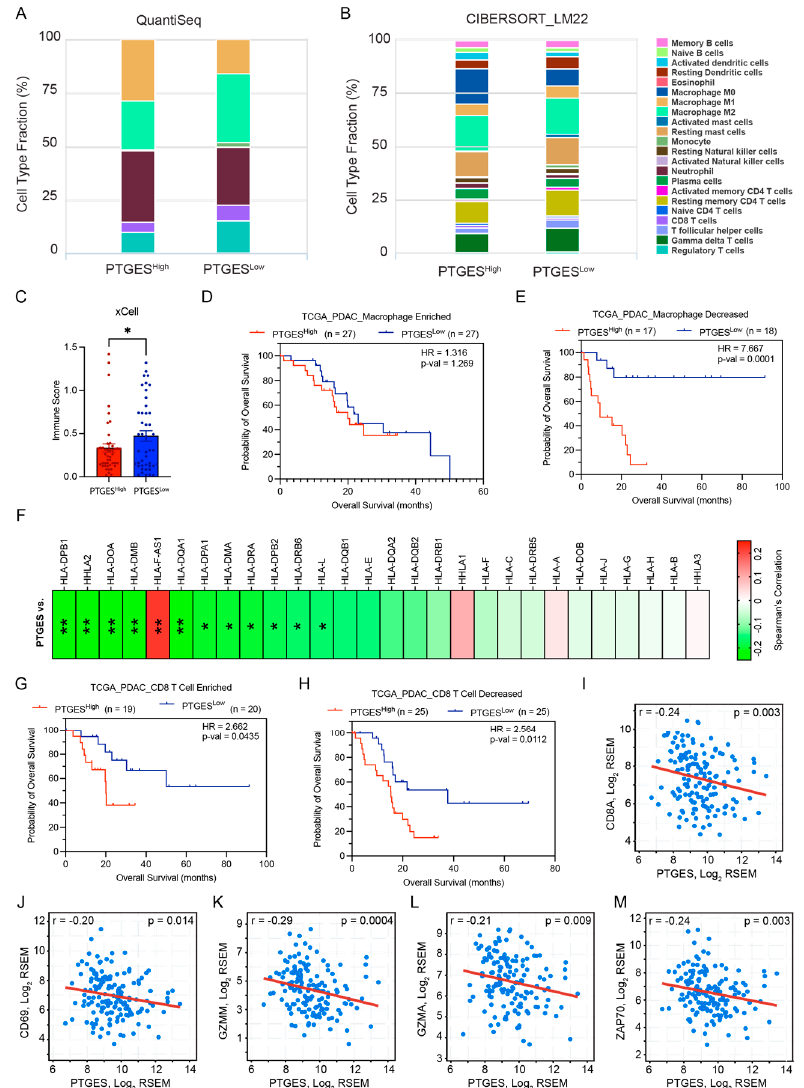
Figure 6. PTGES is associated with an altered immune microenvironment in pancreatic cancer. ( A ) The percentage distribution of six immune cells between the PTGES High and PTGES Low patient groups based on QuantiSeq analysis from the Cancer Immunome Database. ( B ) The percentage distribution of multiple immune cells between the PTGES High and PTGES Low patient groups based on CIBERSORT analysis using the LM22 signature from the Cancer Immunome Database. ( C ) The total immune score calculated through xCell software between PTGES High and PTGES Low PDAC patients. ( D , E ) Kaplan–Meier survival plots of overall survival differences between upper and lower quartiles of PTGES expression in PDAC patients with enriched ( D ) or decreased ( E ) macrophage populations. ( F ) Heatmap showing Spearman’s rank correlation of MHC I and II gene expression with PTGES expression in pancreatic cancer patients from the TCGA PAAD data. The p -value significance of correlations is shown inside the cells. ( G , H ) Kaplan–Meier survival plots of overall survival differences between upper and lower quartiles of PTGES expression in PDAC patients with enriched ( G ) or decreased ( H ) CD8 T cell populations. ( I – M ) Spearman’s rank correlation plots of the CD8A gene and other marker genes (CD69, GZMM, GZMA, and ZAP70) activated in CD8+ T cells with PTGES expression in PDAC patients. The p -values are denoted by * < 0.05, and ** < 0.01.